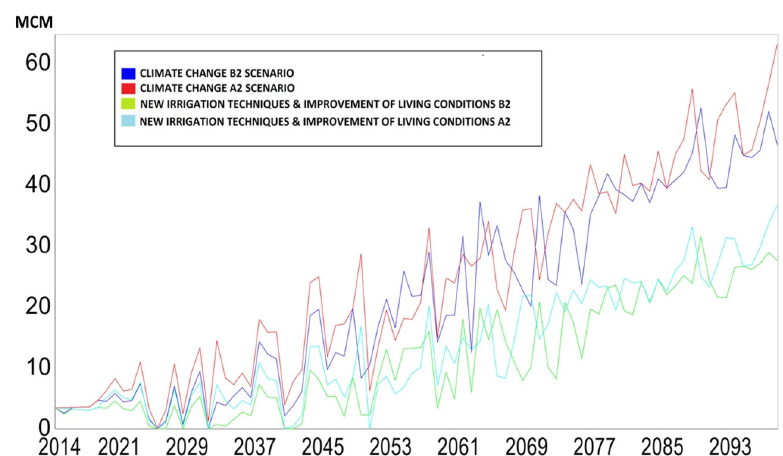
Figure 11. Change in unmet water demand under climate change scenario associated with the combination of two adaptation strategies.